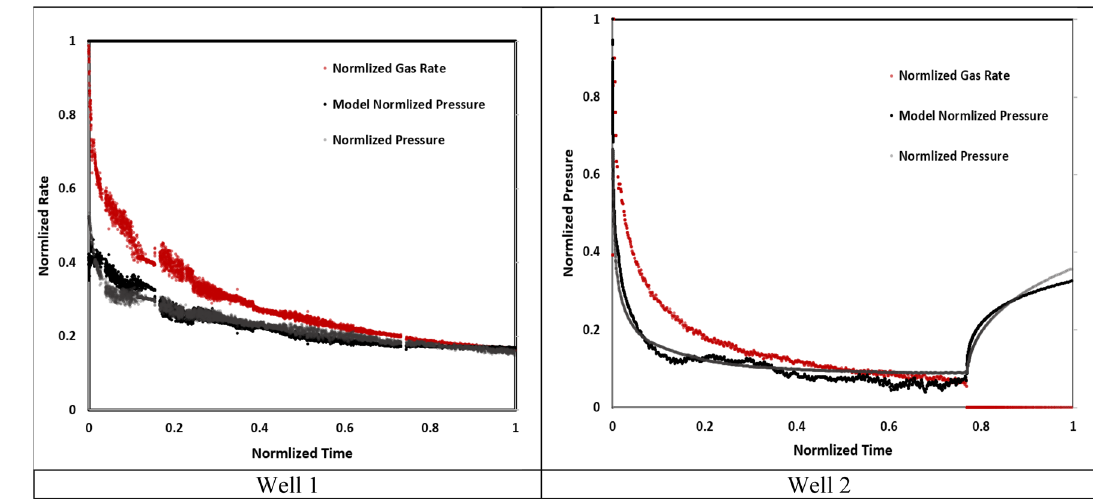
Fig. 6 Well production history match Table 1 Initial and final distribution of uncertain completion parameters